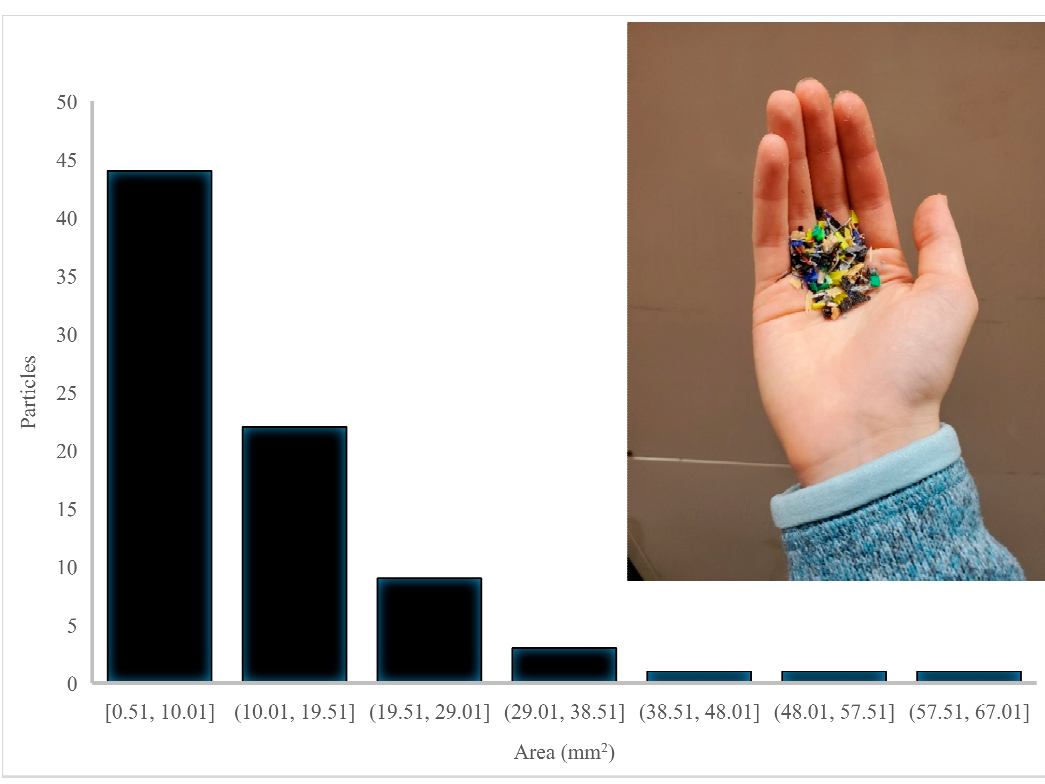
Figure 10. Resultant particle size distribution in mm 2 after shredding in the open source granulator. Inset: picture of shredded PLA from failed 3D prints.